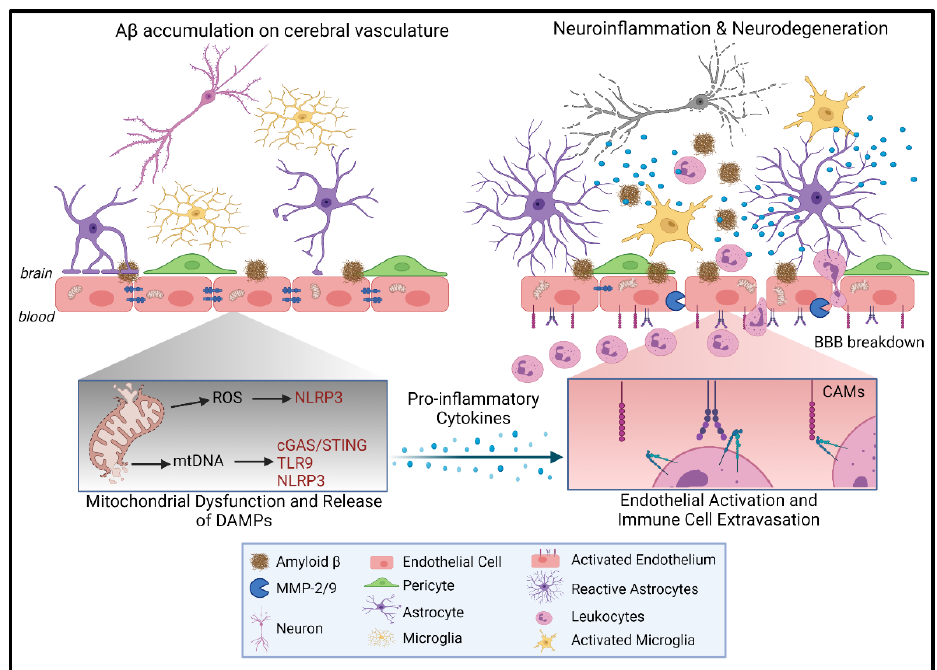
Figure 2. Vascular inflammation and immune cell extravasation drive neuroinflammation and neurodegeneration. The Aβ-mediated release of mitochondrial DAMPs, such as mitochondrial reactive oxygen species (mtROS) and mitochondrial DNA (mtDNA), from endothelial cells (EC) induces a perivascular inflammatory response. This in turn, results in EC activation, characterized by the expression of cell adhesion molecules (CAMs). These CAMs, expressed on the EC membrane, induce the recruitment of circulating immune cells through receptor binding. Immune extravasation occurs through the blood–brain barrier (BBB) due to loss of BBB integrity. Loss of BBB integrity is mediated by the matrix metalloproteinases (MMP) MMP2 and MMP9 and the downregulation of tight junction proteins. Infiltrated immune cells also secrete pro-inflammatory cytokines resulting in activation of astrocytes and microglia, which then release additional pro-inflammatory cytokines. This perpetuated immune activation leads to neurovascular cell damage and neurodegeneration. Figure created with BioRender.com.